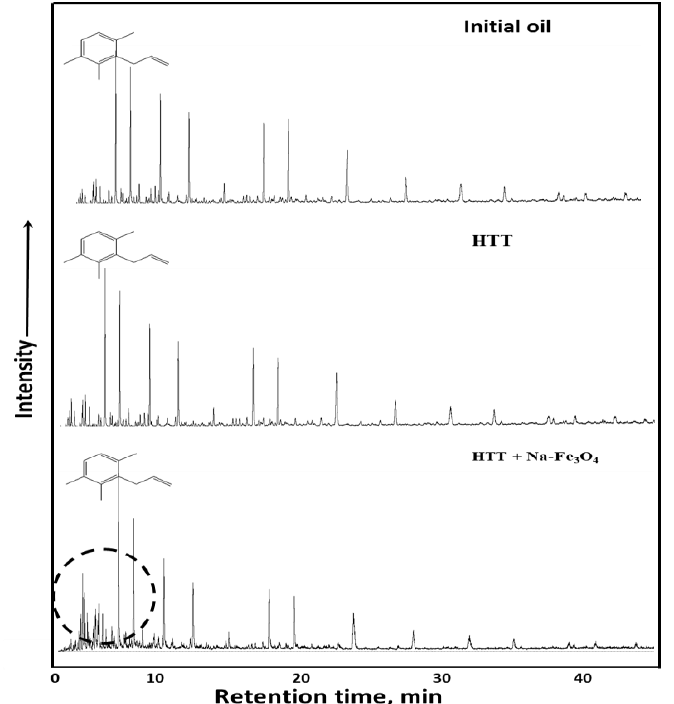
Figure 13. GC-MS spectra of 1,3,4-tri-methyl-2-alkyl-benzenes in the composition of aromatics by m / z = 134.